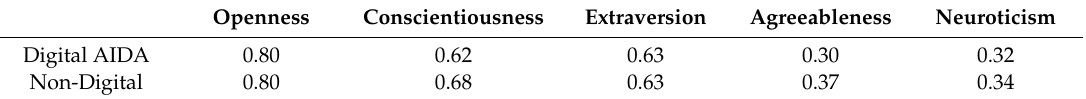
Table 2. Average percentile scores for Big Five personality